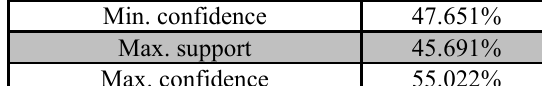
Table 15. Correlated requests